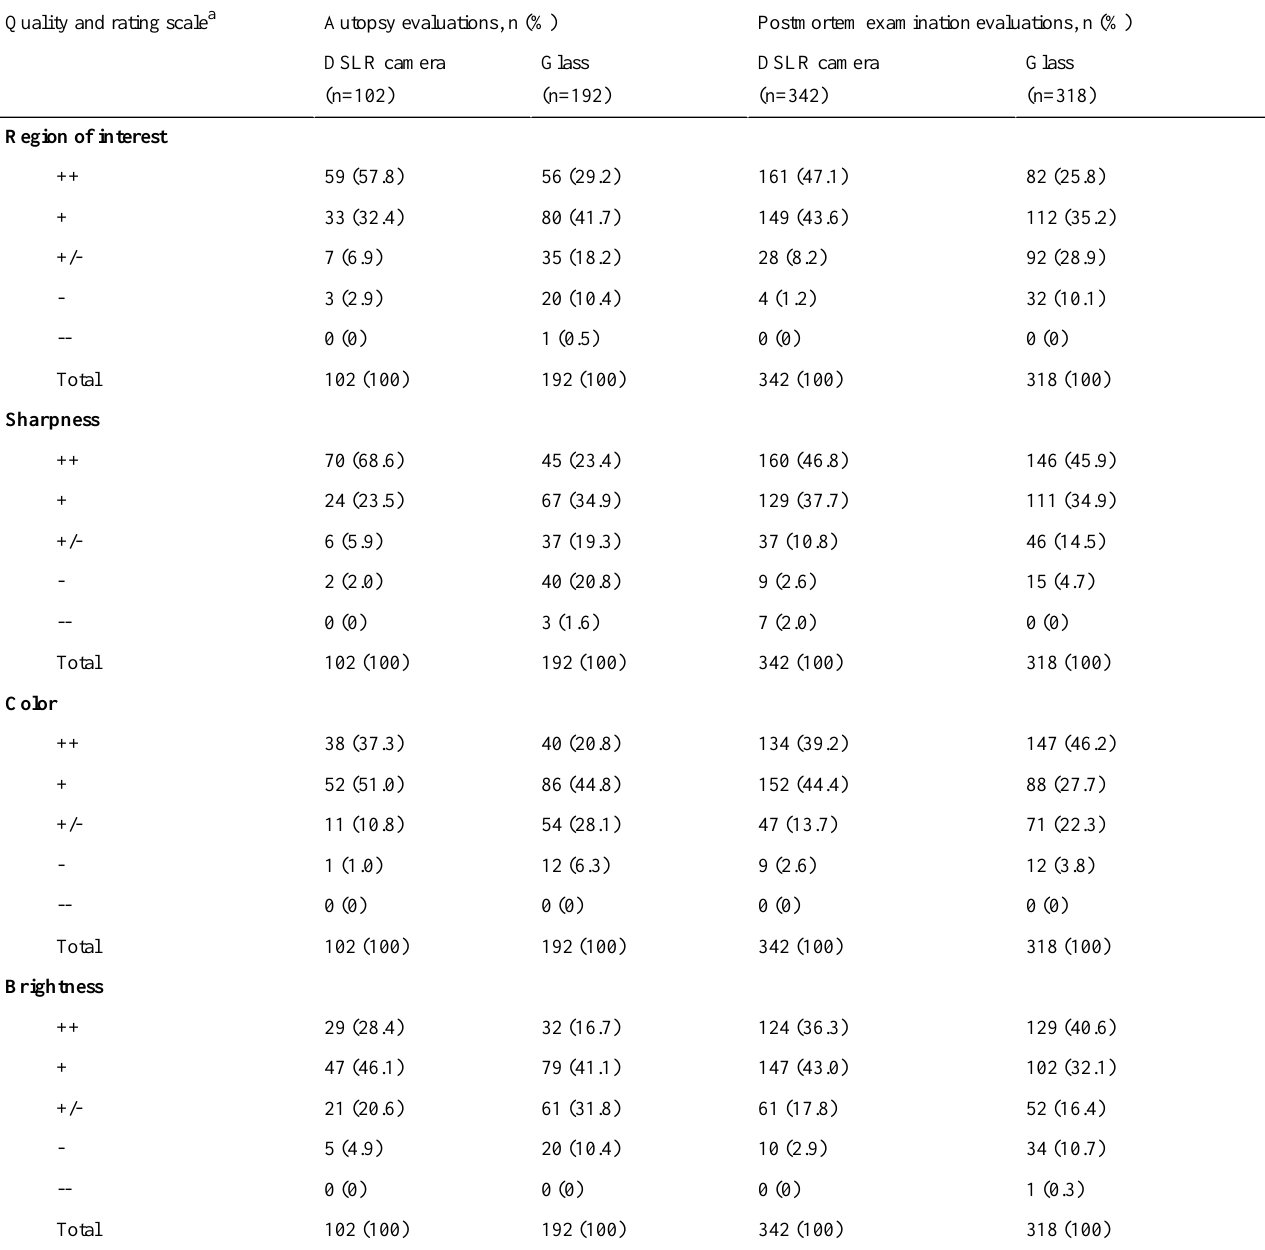
Table 2. Frequencies (n) and percentages (%) of evaluations given by 6 raters for images taken during autopsy (n=294) and postmortem examination (n=660) with a digital single-lens reflex (DSLR) camera and Google Glass.